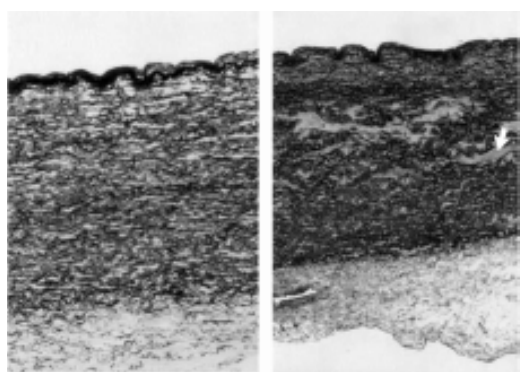
Fig. 3A and 3B - On the left (3A), transversal histological section of the pulmonary artery of a 42-year-old patient. The elastic tissue, despite being more fragmented than in the ascending aortic artery, maintains the organization of the media layer. The small areas in yellow represent accumulations of collagen. On t he right (3B), transversal histological section of the pulmonary artery of a 40- year-old patient with bicuspid aortic valve, submitted to the operation of Ross. Note the disorganization of the media layer with important alterations in the orientation of the smooth muscle cells and an intense accumulation of mucopolysaccharides in its central area (cystic necrosis of the media layer). Staining method: Movat pentachromic stain. Magnification: 100